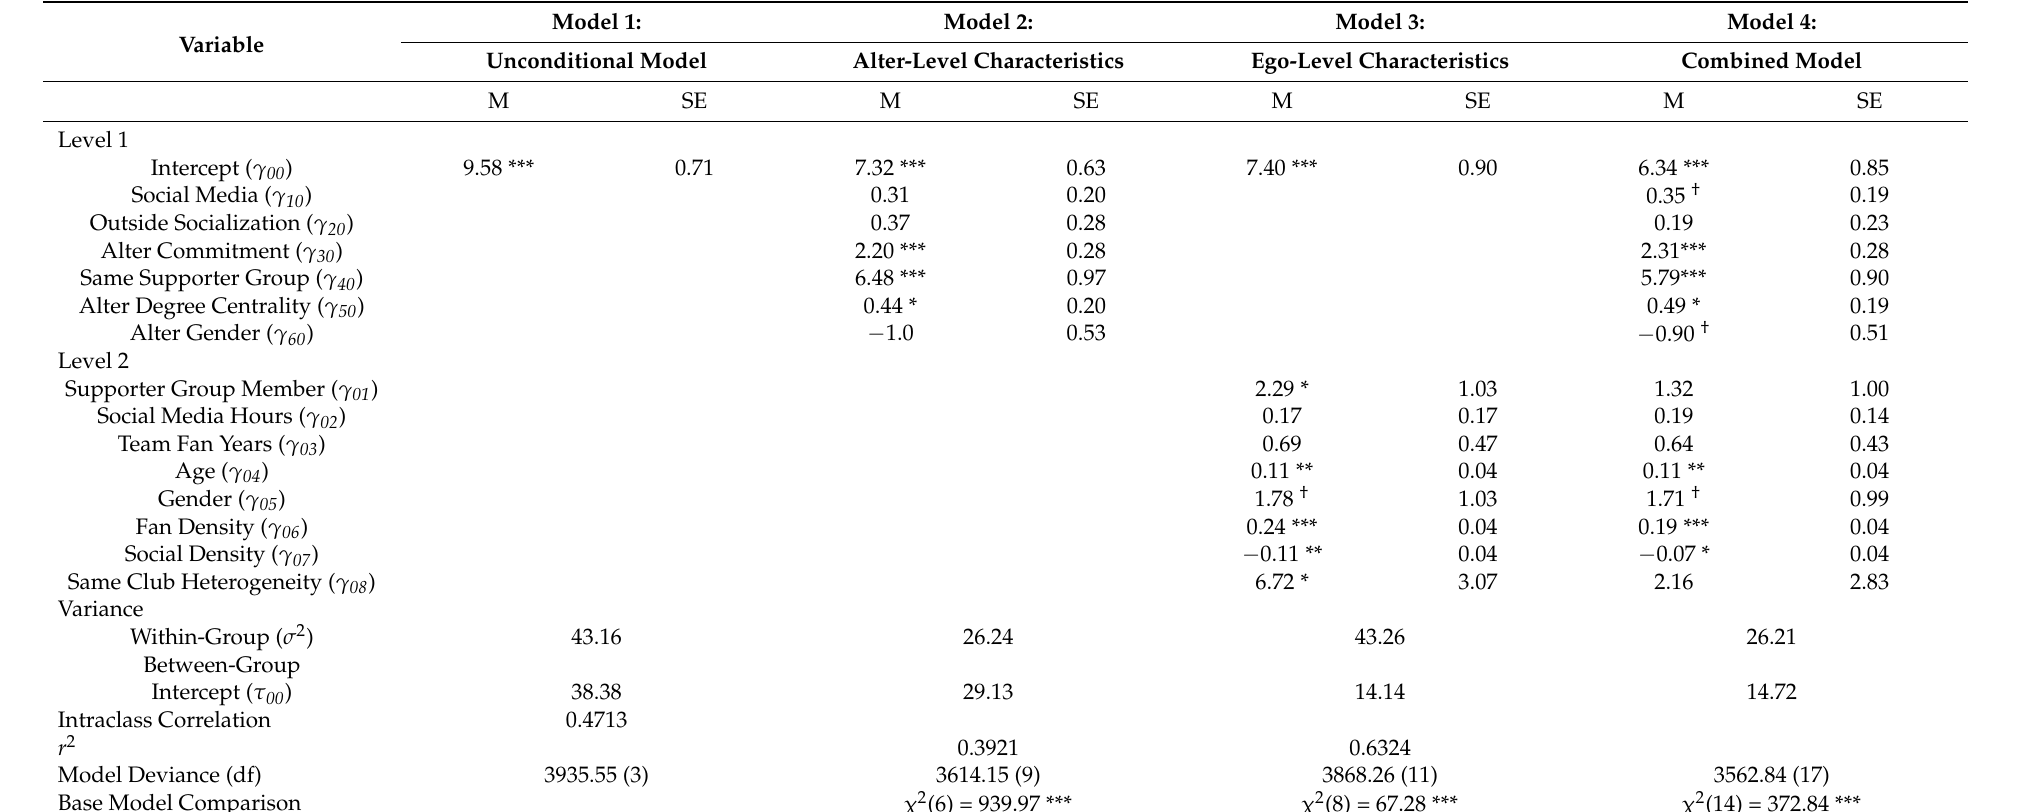
Table 2. Hierarchical linear modeling results for